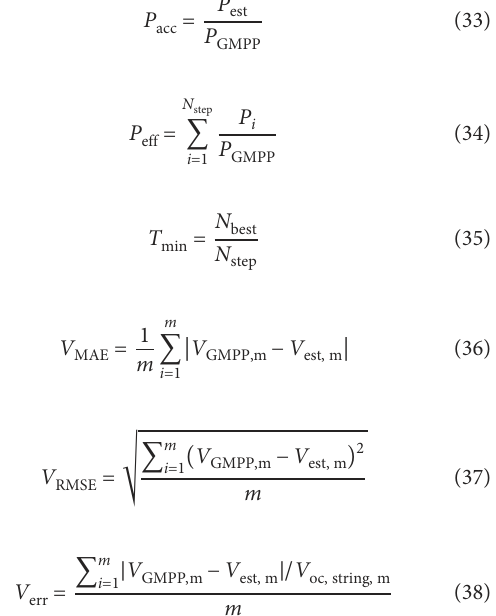
FIGURE 7 P-V curves and GMPP trajectory under considered PSCs for step test.